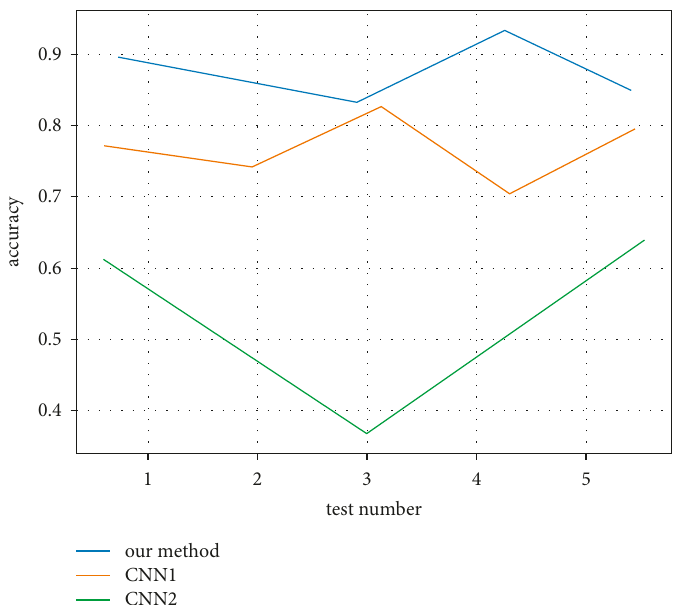
Figure 10: Classification accuracy of different models.